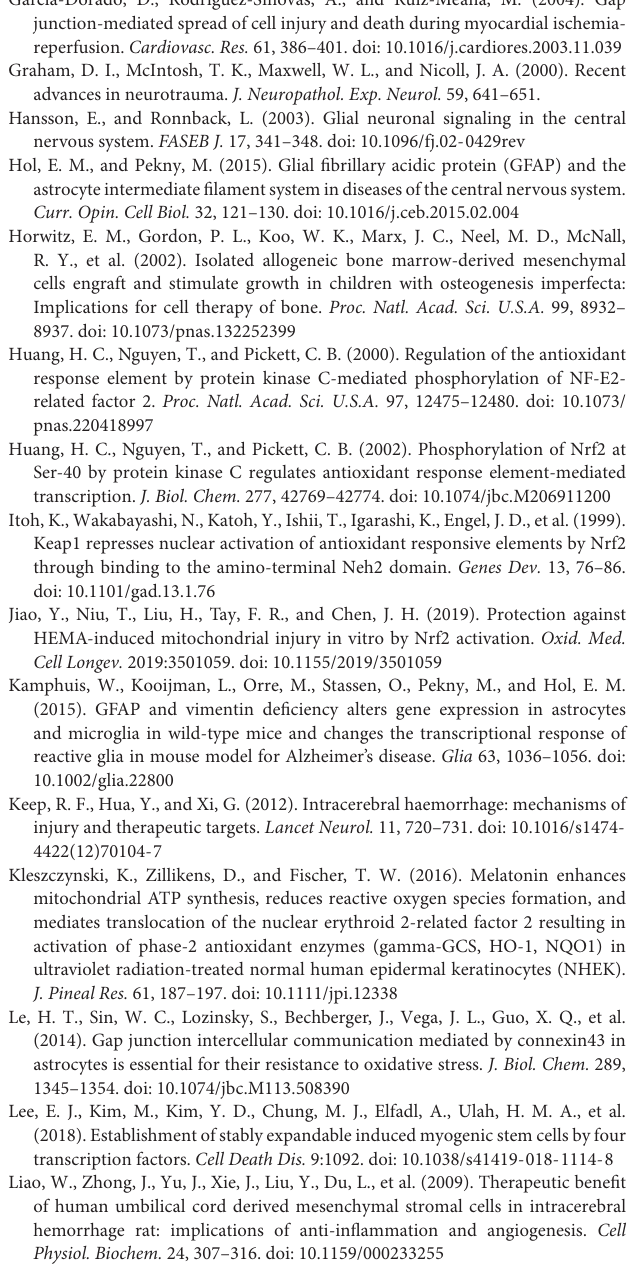
FIGURE S3 | Cx43 knockdown suppressed BM-MSCs-induced p-PKC α expression. (a,b) Western blotting analysis of p-PKC α and PKC α expression in control, si-NC, si-Nrf2 transfected astrocytes. All data are displayed as means ± SD ( n = 3). The difference between groups was analyzed using One-way ANOVA test. * p < 0.05, ** p < 0.01. FIGURE S4 | Diagram outlining the potential mechanism of BM-MSCs enhancing astrocytes antioxidative function via the Cx43/Nrf2/HO1 axis. BM-MSCs induced Cx43 upregulation, PKC α phosphorylation, Nrf2 stabilization and nuclear translocation, and upregulation of HO-1, then restraining ROS accumulation and cell